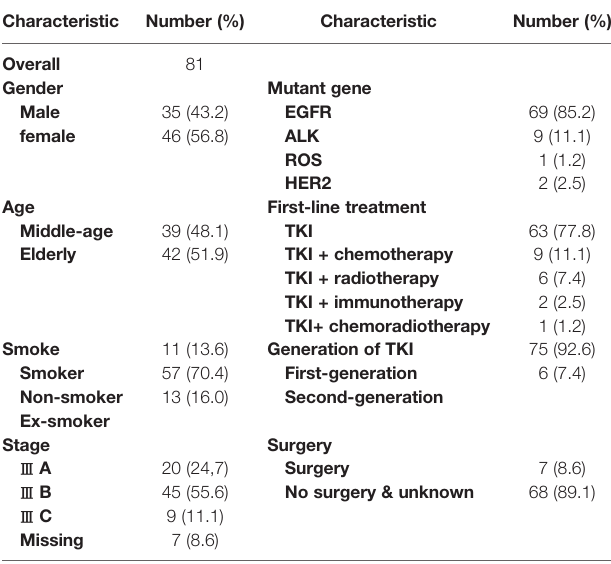
TABLE 1 | Characteristics of involved 81